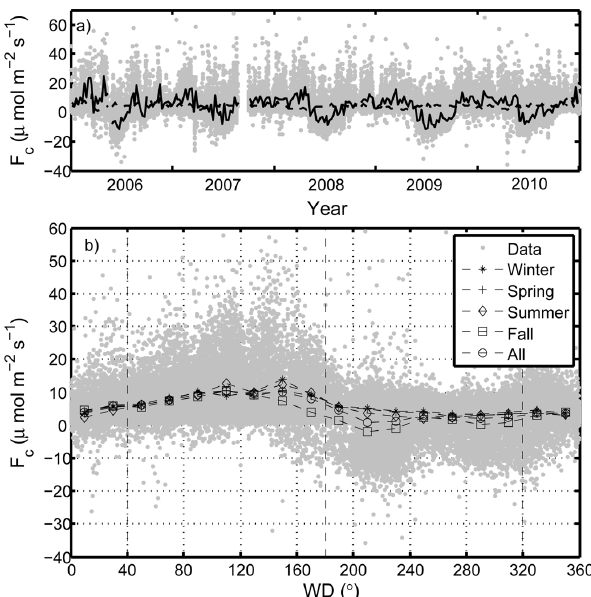
Fig. 4. (a) The measured half hour CO 2 flux ( F c , grey dots) and the 7-day averages calculated from daytime (10:00–14:00, solid line) and nocturnal (PAR < 5µmolm − 2 s − 1 , dashed line) data, and (b) variation of F c as a function of wind direction. Besides 30-min averages (grey dots), the bin averaged fluxes (20°) for all data and separately for different seasons are plotted. The limits of built (320– 40°), road (40–180°) and vegetation (180–320°) sectors are marked with dashed vertical lines.